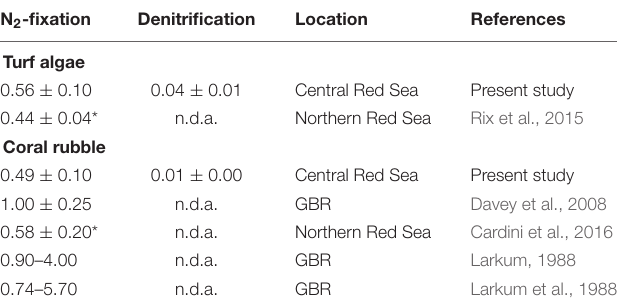
TABLE 2 | N 2 -fixation (nmol N 2 cm − 2 h − 1 ) and denitrification (nmol N 2 O cm − 2 h − 1 ) rates of turf algae and coral rubble in comparison with values